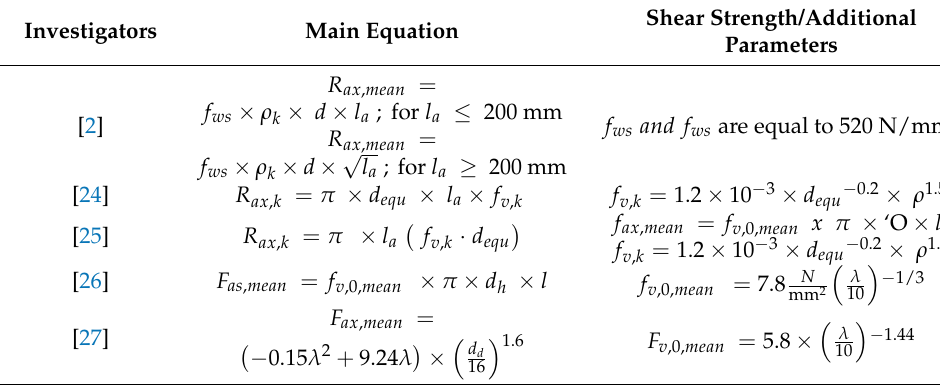
Table 2. The Concept of the Derived Equation and Variables